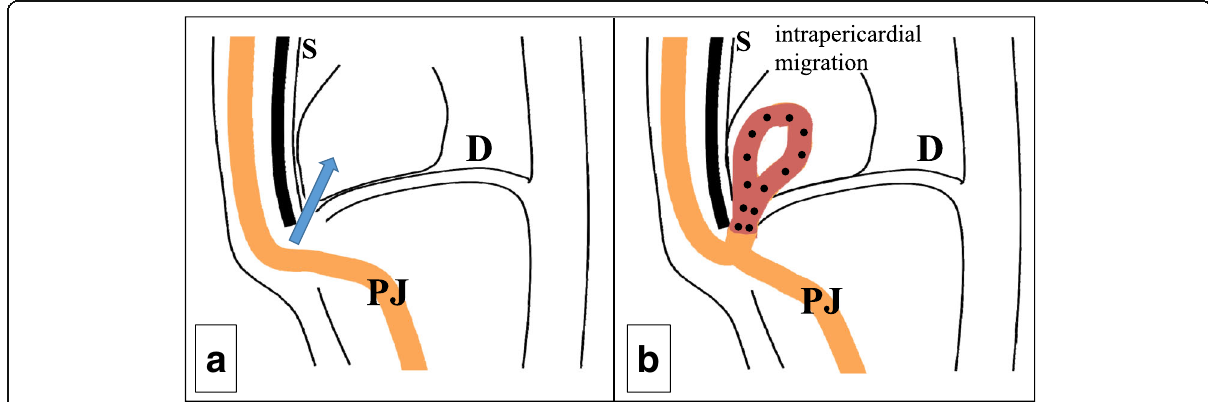
Fig. 3 Schematic illustration of a the antethoracic reconstruction and b the completed herniation. PJ : pedicled jejunum, D : diaphragm, S : sternum